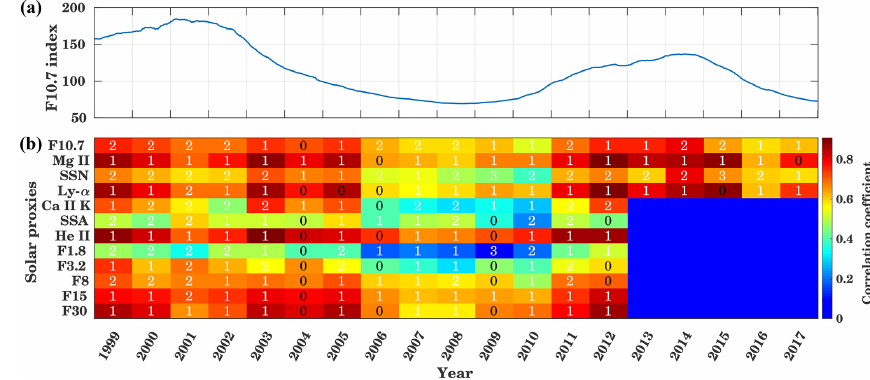
Figure 9. In panel (a) , the 365d running mean time series of F10.7 is shown. Panel (b) displays yearly cross-correlations and time delays between GTEC and different solar proxies for the years 1999 to 2017 at the timescale of 16 to 32d. The background colors give the maximum correlation coefficient, and the inserted numbers show the delay in days corresponding to maximum